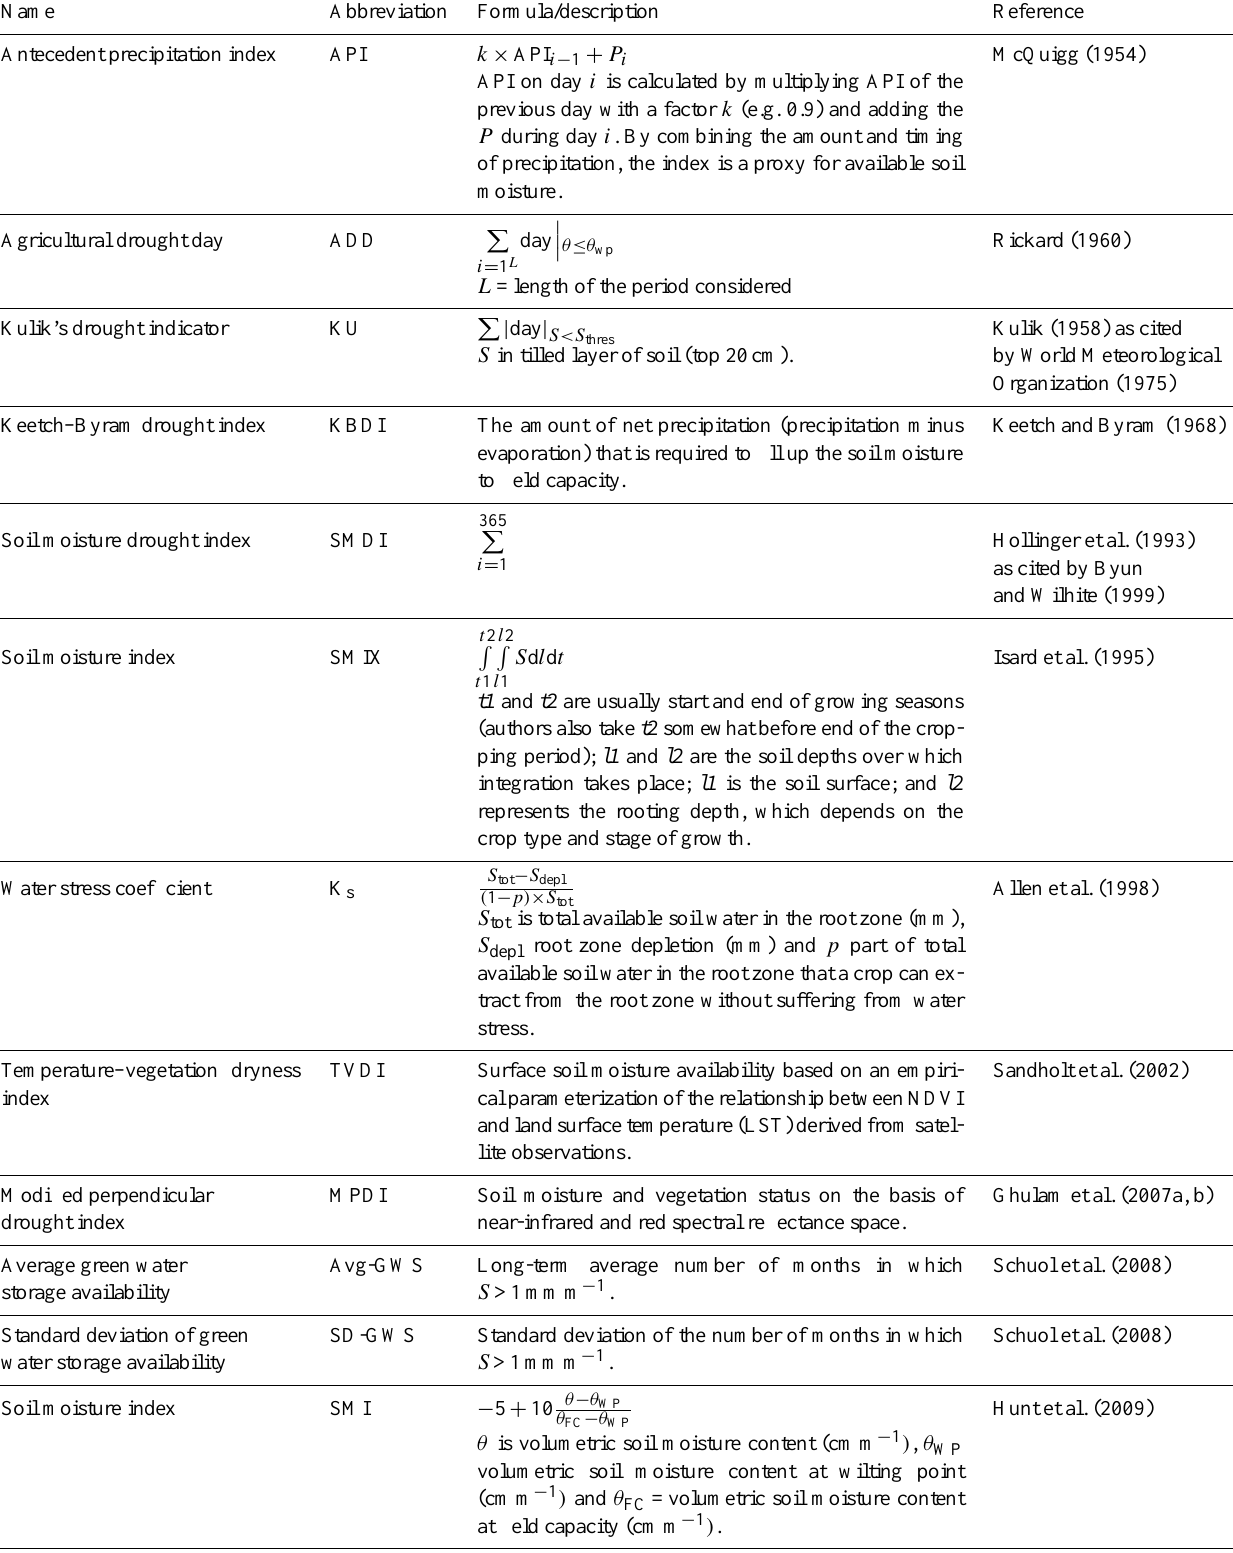
Table A3. Absolute soil moisture